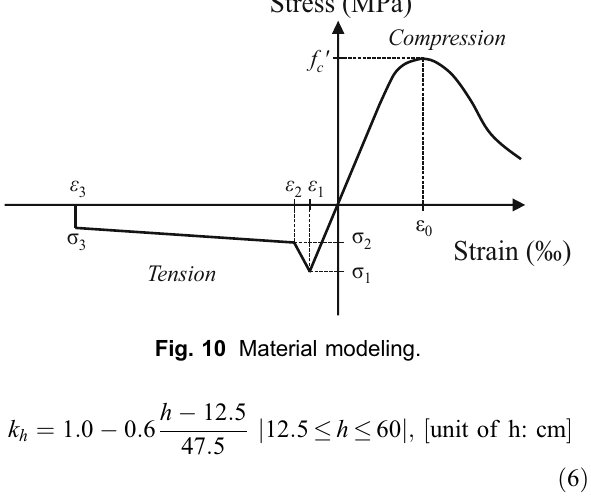
Fig. 12 Fracture energy versus COD